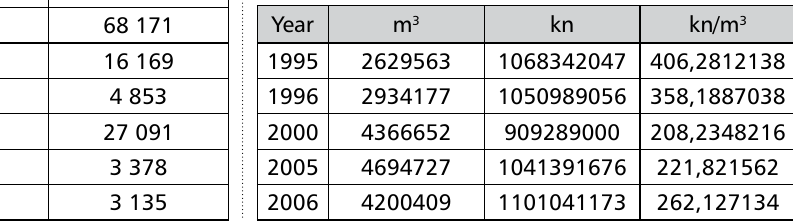
Value and quantity of felled roundwood for “Hrvatske šume” ltd. Real prices, equated to